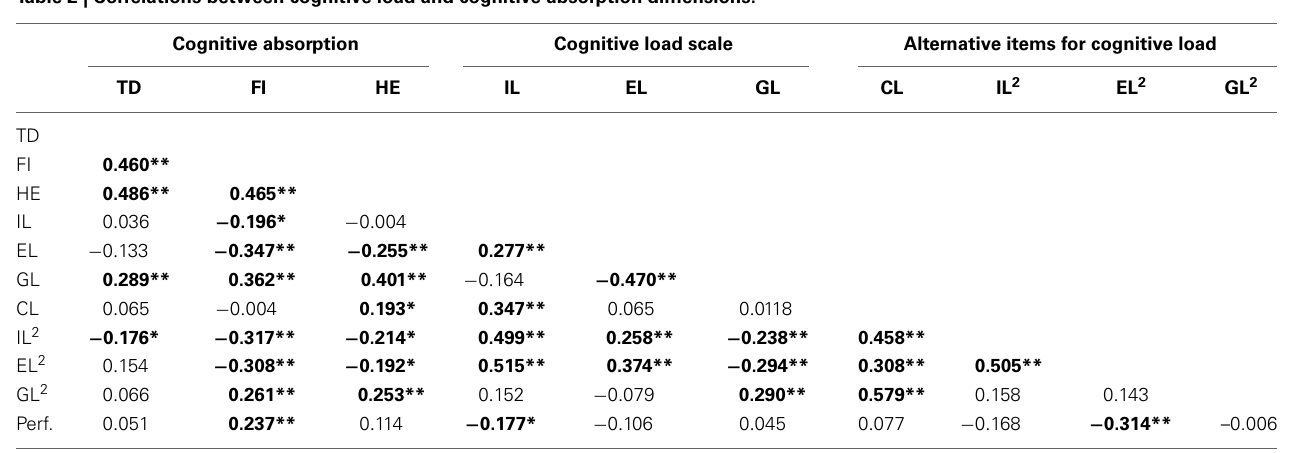
Table 2 | Correlations between cognitive load and cognitive absorption